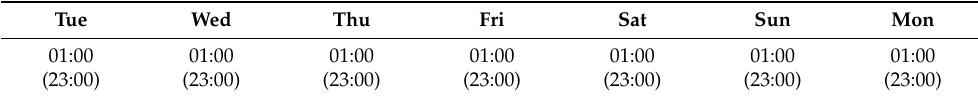
Figure 4. Hits “suicide” and “depression” for Great Britain–trend-seasonal decomposition. Table 8. Average hits–suicide